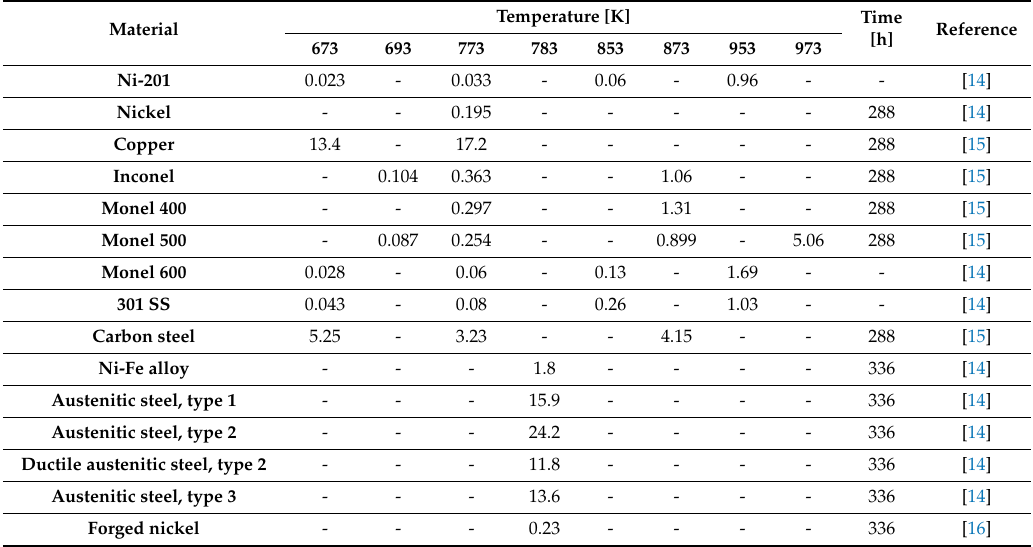
Table 1. Corrosion rates of selected materials in molten NaOH in mm year − 1